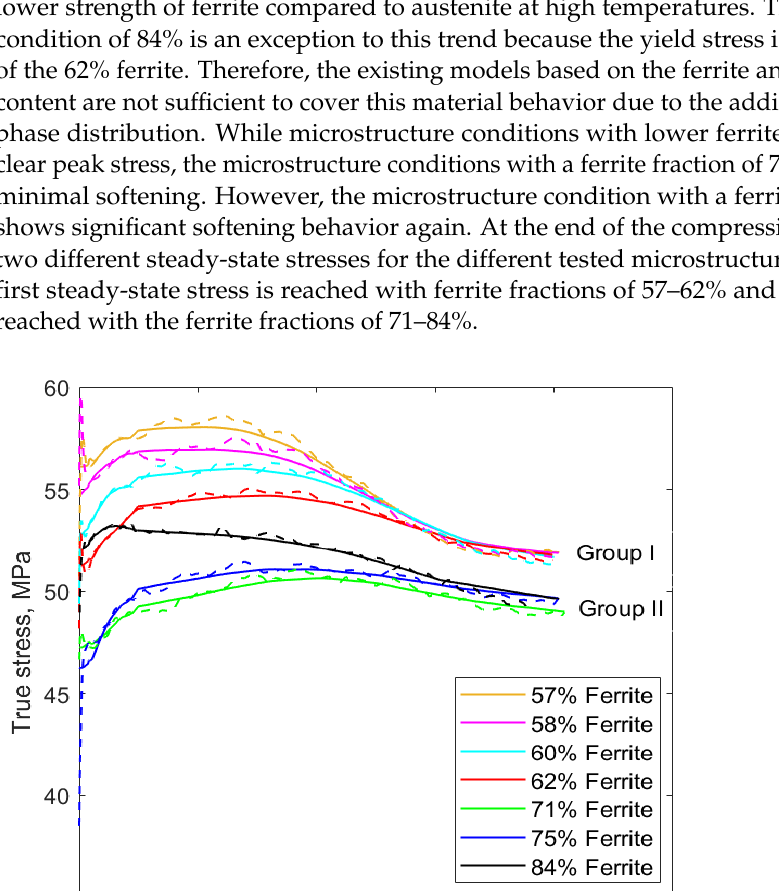
Figure 3. True stress vs. true strain curves from compression tests for different ferrite starting volume fractions at 1100 °C and 0.1 s −1 . Dashed lines indicate original data and continuous lines indicate smoothed data as inputs for the model.